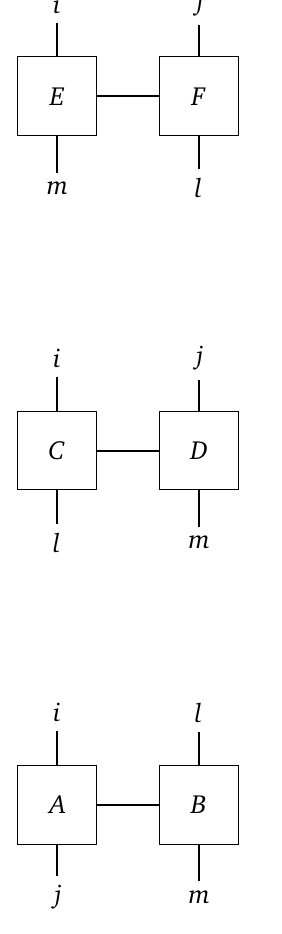
Figure 31: Three representations of the same tensor network are shown. In each there is a single contraction over a single pair of indices between the two tensors, as well as two external indices on each. These are all of the unique factorizations of a rank 4 tensor into a network of two rank 2